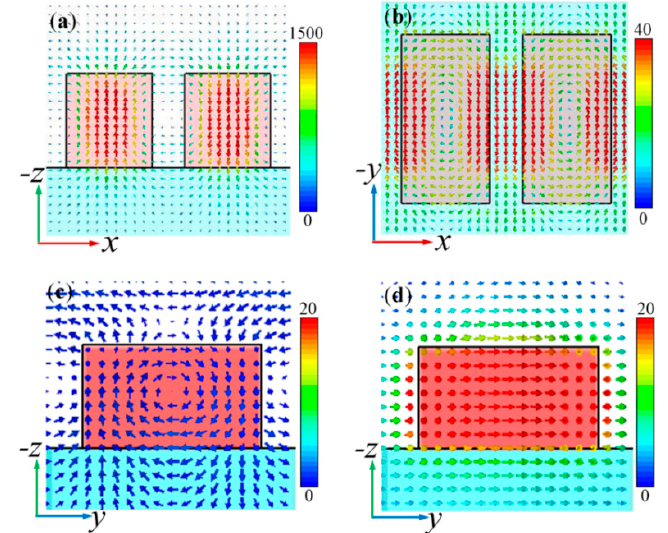
Figure 4. ( a ) Magnetic field profile in the x – z plane at y = 0 nm, and ( b ) electric field profile in the x – y mid-plane at the EIT peak. ( c ) and ( d ) correspond to electric field profiles in the y – z plane at x = 200 nm at the right dip of the EIT and at the EIT peak, respectively. The color scales represent the corresponding field enhancement.